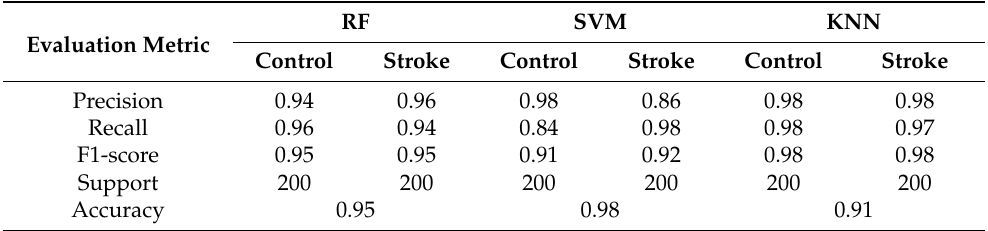
Table 7. Classification Report of the three classification models after data balancing (Borderline- SMOTE).